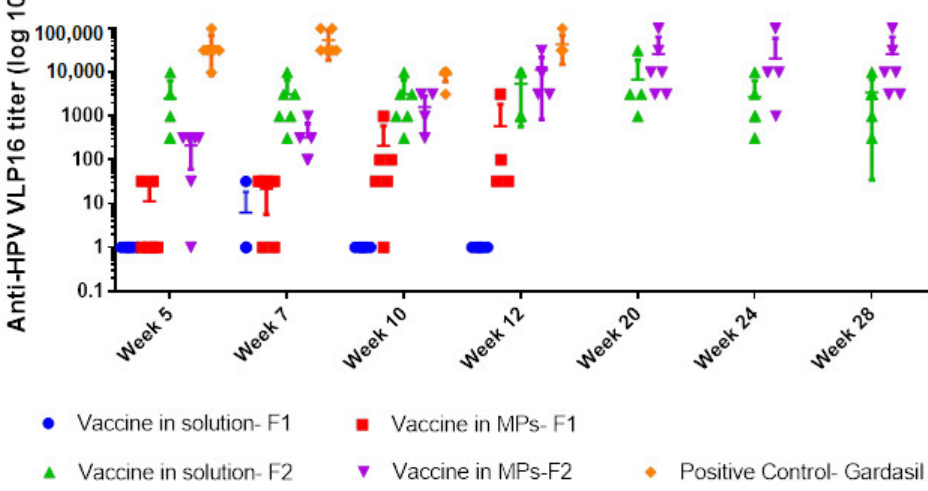
Figure 4. Western blot images of Formulations 1 and 2. ( A ): Formulation 1. Lane 1, 2: HPV16 VLPs in MPs (1.0 and 0.5 μg), Lane 3, 4, 5, 6, 7 and 8: blank MPs + HPV 16 VLPs in solution (1.0, 0.5, 0.25, 0.125, 0.06 and 0.03 μg), Lane 9: Blank MP. ( B ): Formulation 2 contained 20% CPD, and HPV16 VLP absorbed into alum and MPL. Lane 1, 2, 3, 4 and 5: VLPs + Blank MPs (2.0, 1.0, 0.5, 0.25 and 0.125 μg), Lane 6: Blank MP, Lane 7, 8 and 9: HPV16 VLPs + Alum + MPL MPs (2.0, 1.0 and 0.5 μg) .